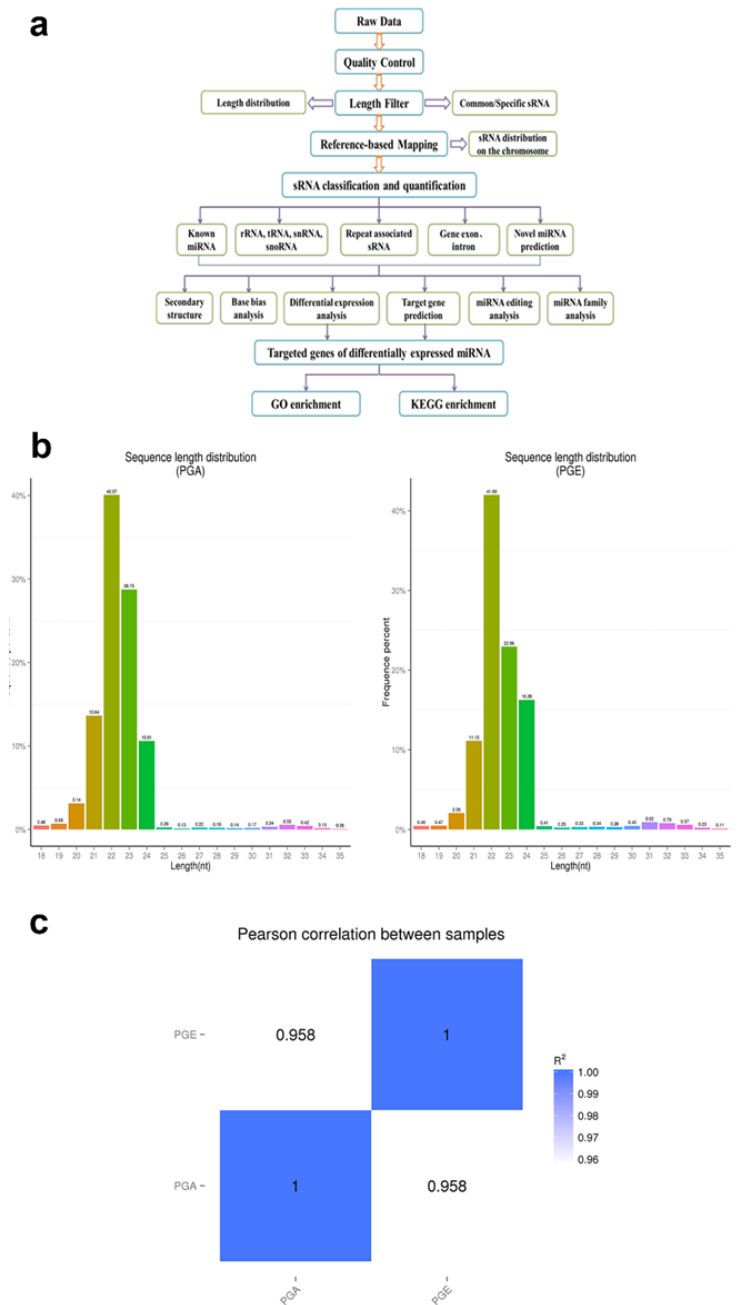
Figure 1. Identification and classification of miRNAs in sheep pituitary. ( a ) Workflow for identifying miRNAs. ( b ) The length distribution of sequence small RNAs in the clean read. ( c ) Schematic diagram of Pearson’s correlation of miRNA expression levels between samples; horizontal axis is the length of miRNA and the vertical axis indicates the abundance of the miRNA. PGA, anestrus pituitary group; PGE, estrus pituitary group.